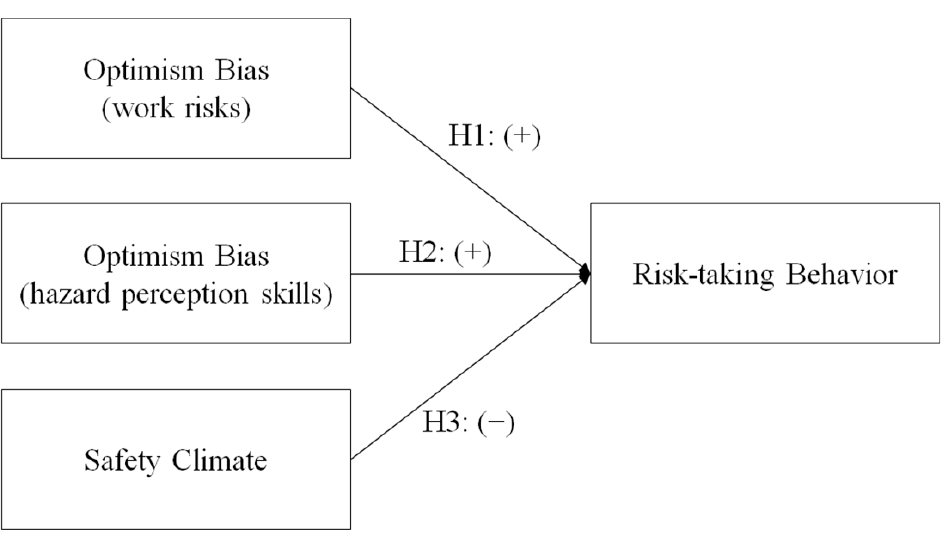
Figure 1. Research model to be tested in the current